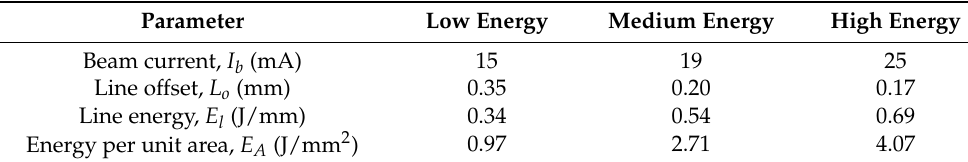
Table 2. Process parameters used for fabrication of